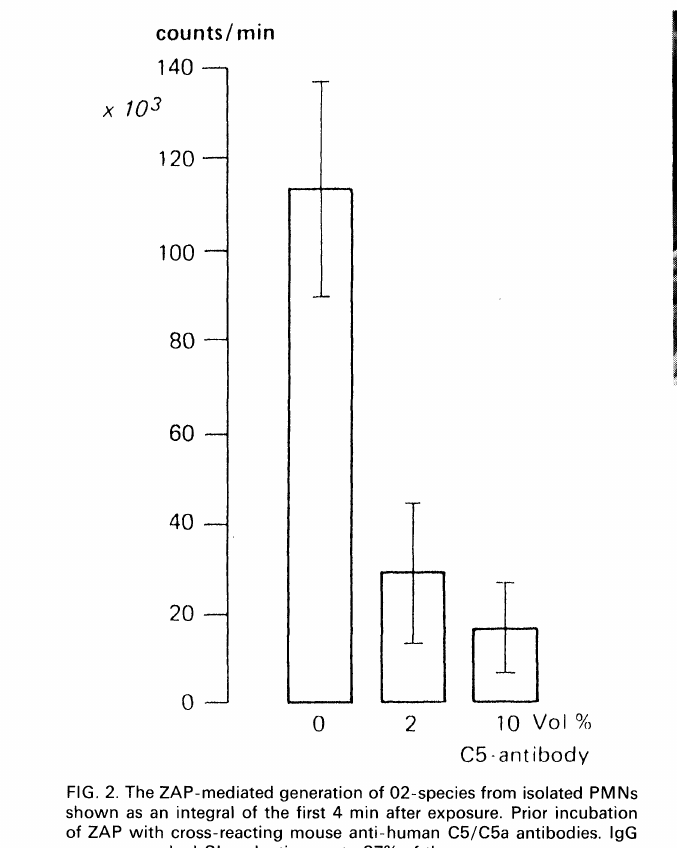
FIG. 2. The ZAP-mediated generation of 02-species from isolated PMNs shown as an integral of the first 4 min after exposure. Prior incubation of ZAP with cross-reacting mouse anti-human C5/C5a antibodies. IgG causes a marked CL-reduction up to 87% of the mean.